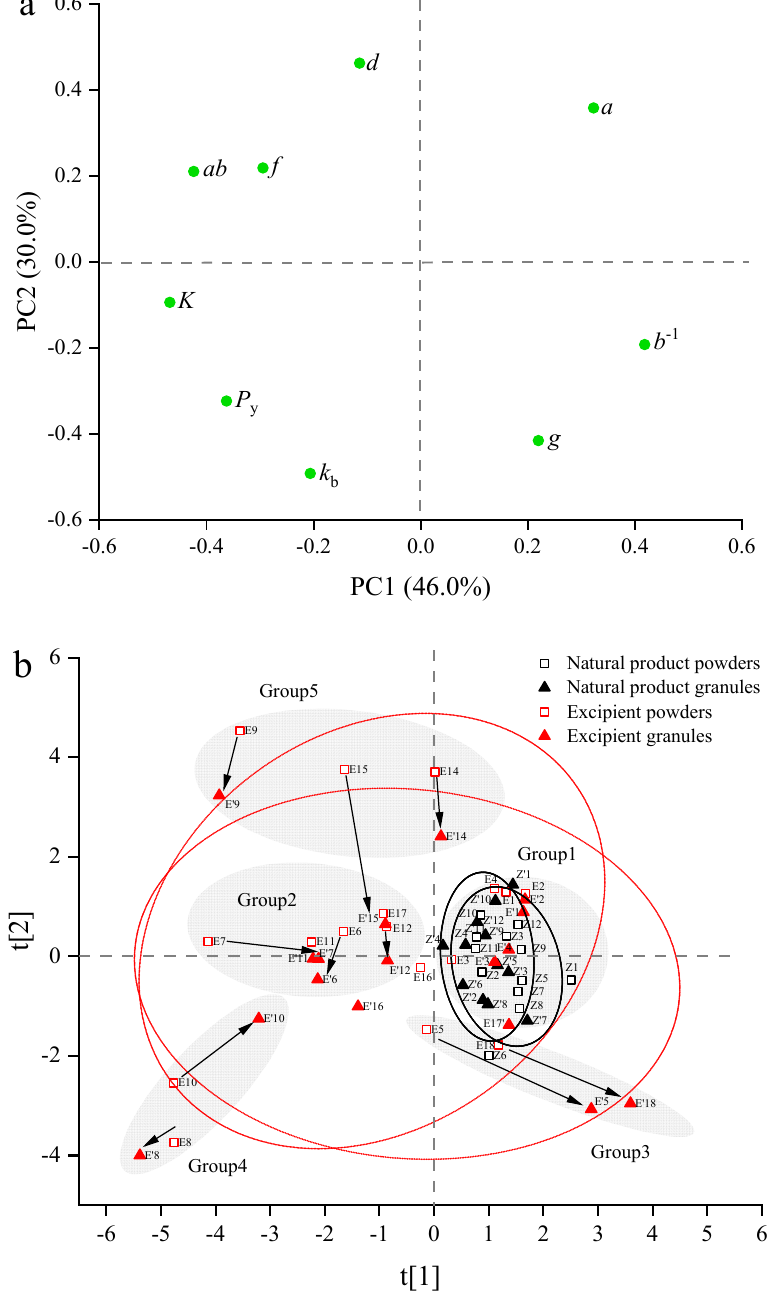
Figure 4. The PCA analysis of the CBCS parameters data based on the first two principal components. ( a ) the loading plot; ( b ) the score plot. (The black squares represent NPPs. The black triangles represent NPGs. The red squares represent excipient powders. The red triangles represent excipient granules. Two black circles are 95% confidence ellipses for NPPs and NPGs, respectively. Two red circles are 95% confidence ellipses for excipient powders and excipient granules, respectively. The gray shaded circles represent five groups of materials).